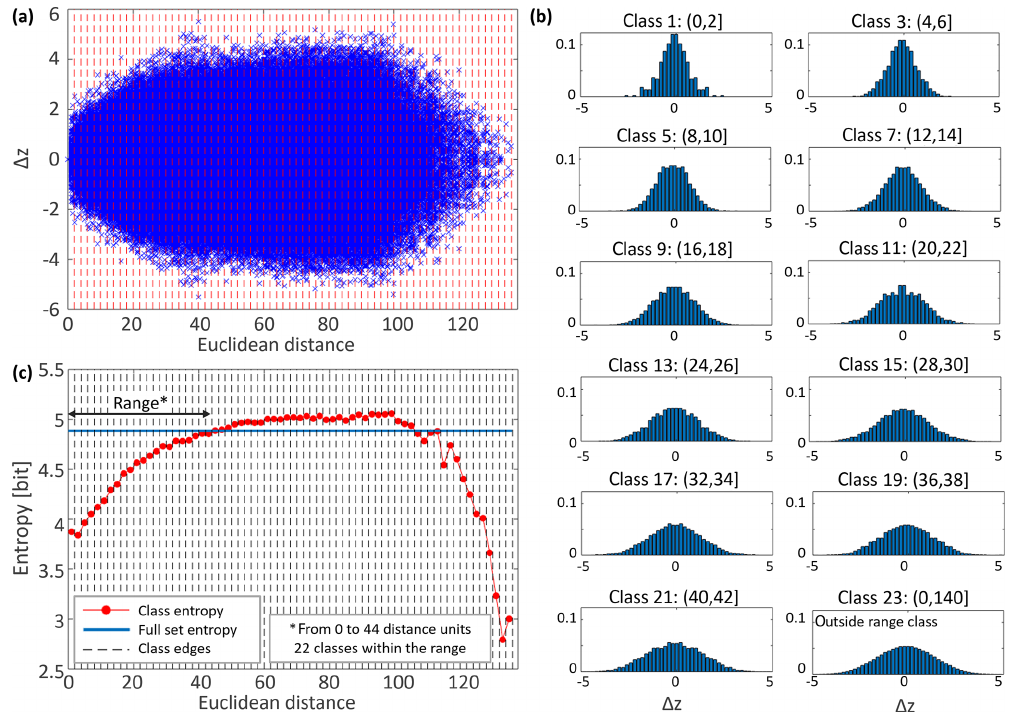
Figure 5. Spatial characterization of LR1-600 showing the (a) infogram cloud, (b) (cid:49)z PMFs by class, and (c)